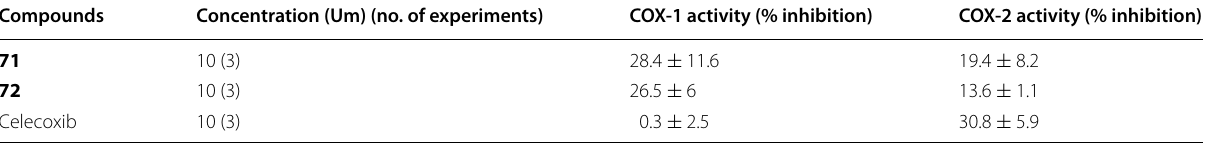
Table 21 Cyclooxygenase inhibition activity of synthesized compound Compounds